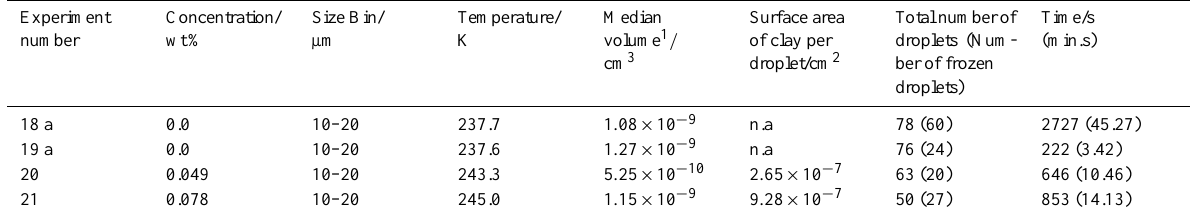
Table 4. Summary of experimental conditions for both homogeneous and heterogeneous isothermal